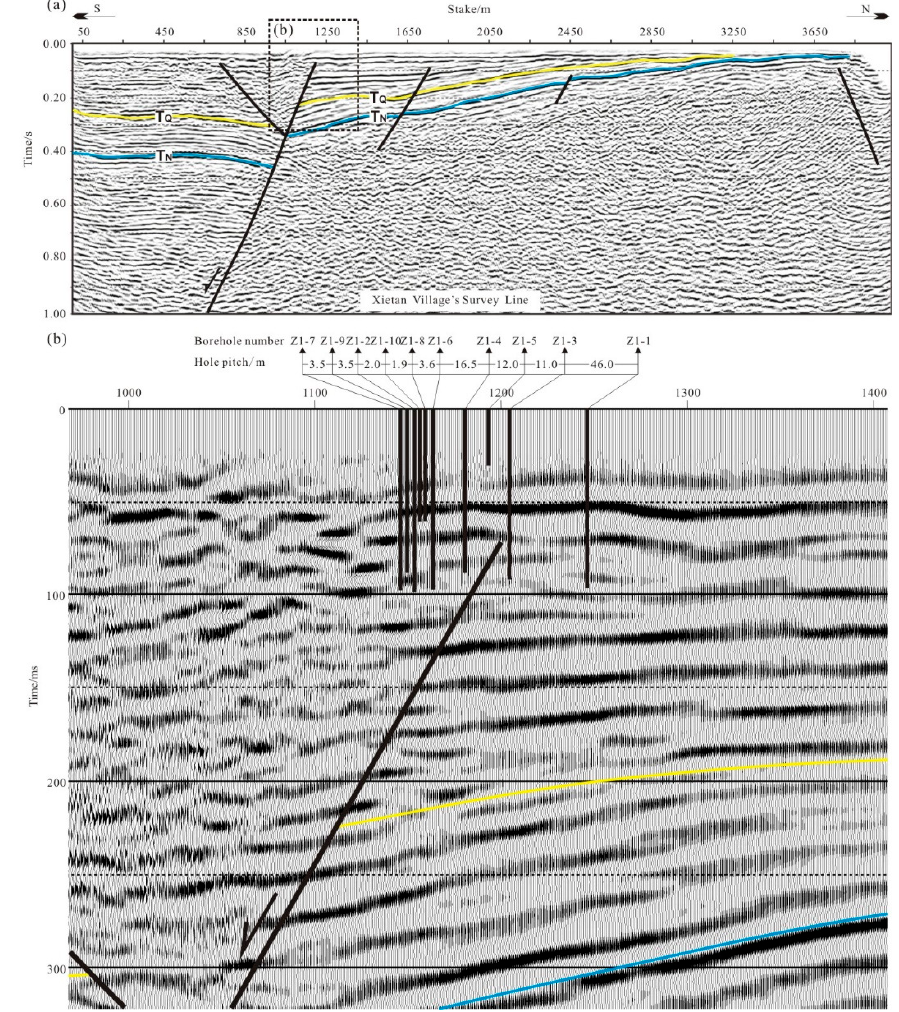
Figure 3. The time profile of Xietan Village’s survey line and the layout of boreholes on composite drilling section in Xietan Village. ( a ) A time-stacked section of the shallow seismic line in Xietan Village. Dashed black box shows the location of ( b ). ( b ) The layout of boreholes on composite drilling section in Xietan